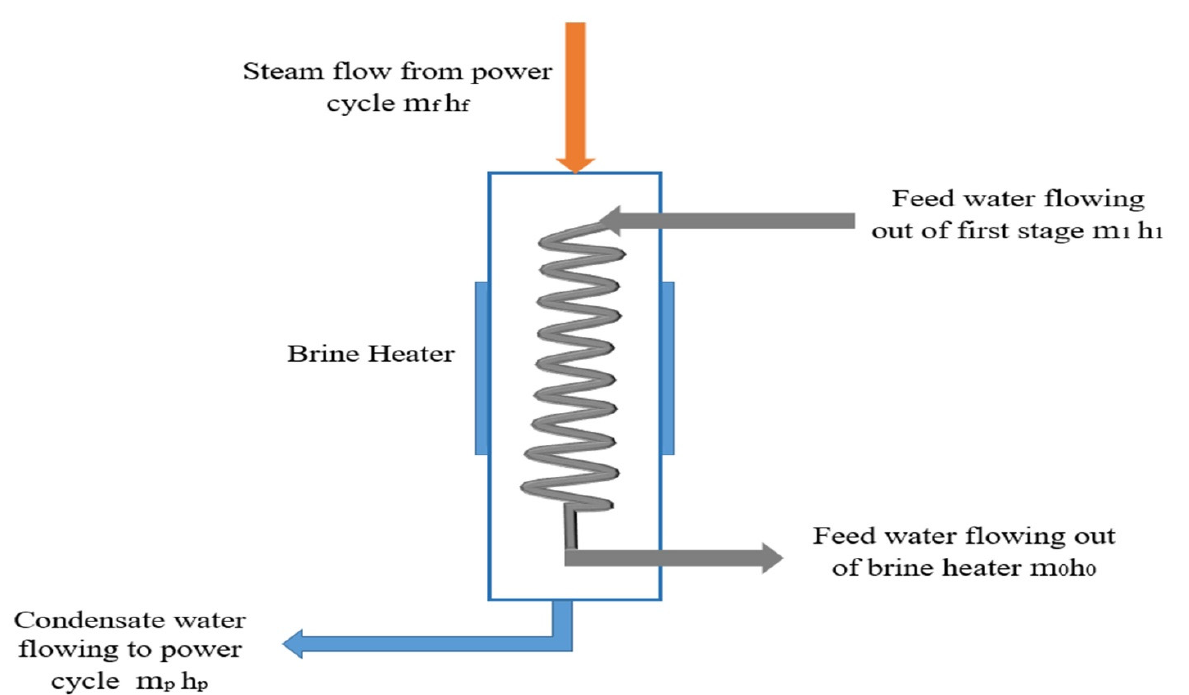
Figure 3. Brine heater: m 1 h 1 , mass flow and enthalpy of feed water; m 0 h 0 , mass flow and enthalpy of feed water coming out of brine heater; m p h p , mass flow and enthalpy of condensate water; and m f h f , mass flow and enthalpy of steam.